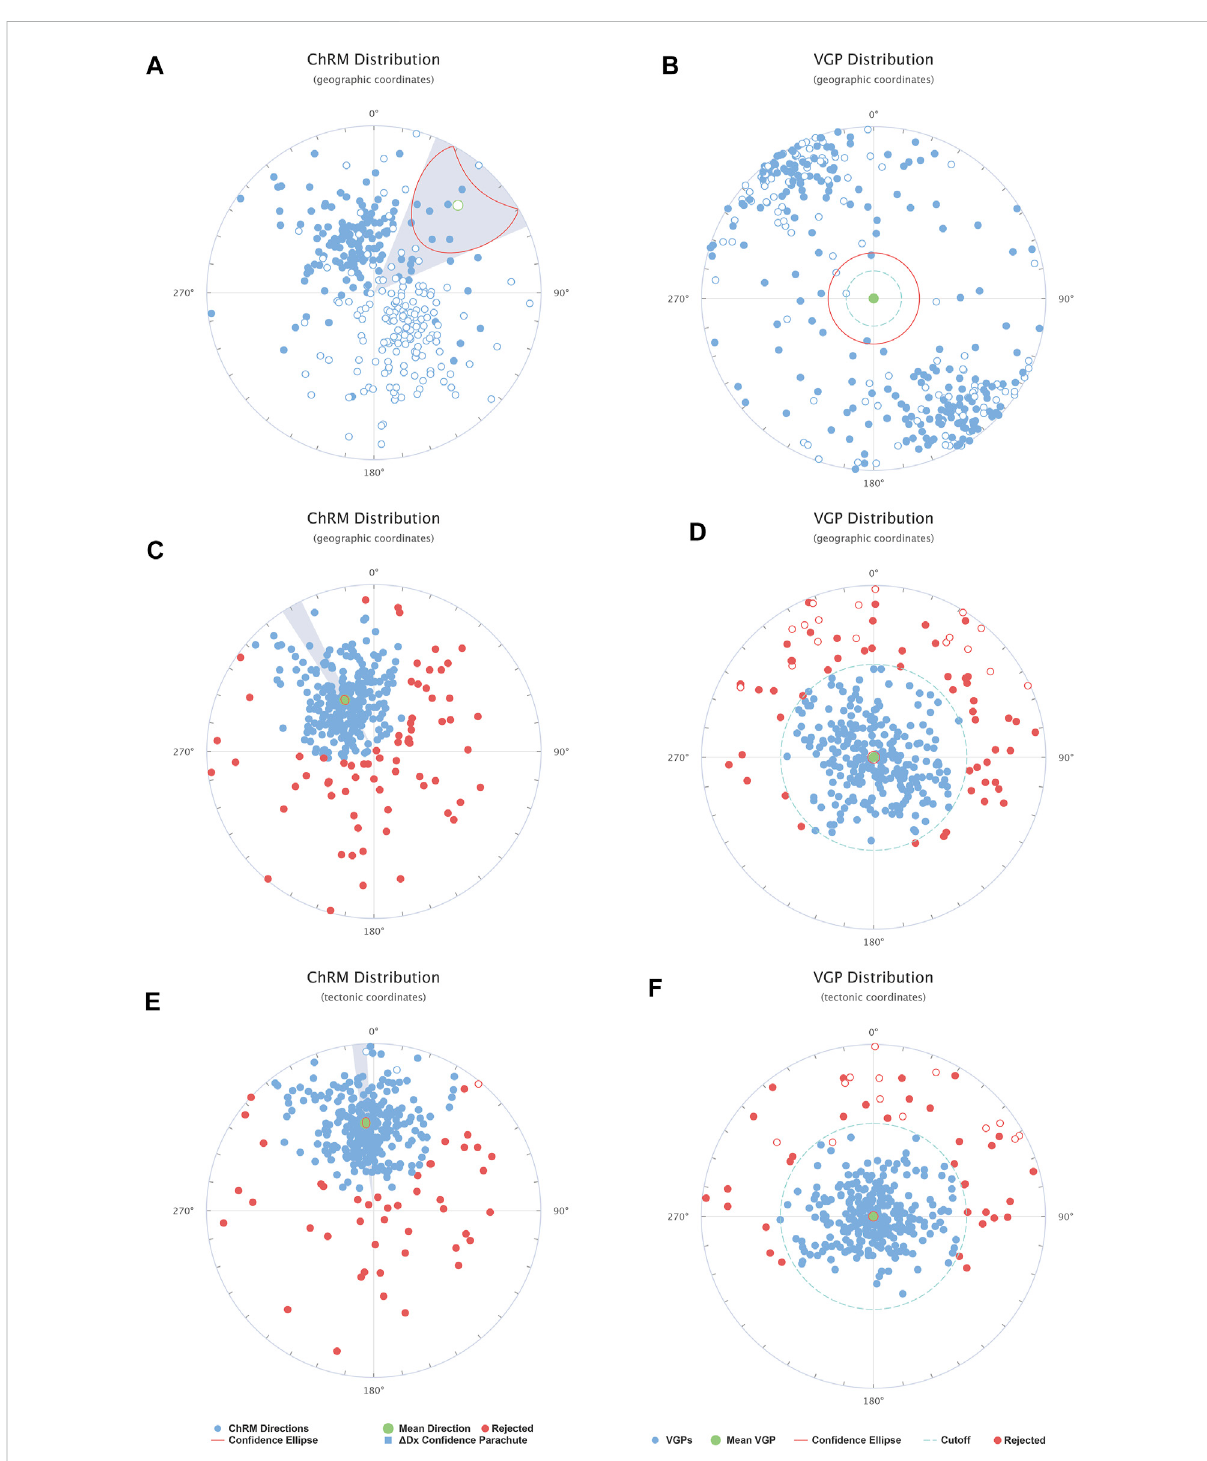
FIGURE 6 In-situ [geographiccoordinates, (A, B, C,D) ]and tilt-corrected[tectonic coordinates, (E, F) ]Equal-area stereographic projection of ChRMs and VGPs from the Yengisar section. (A) and (B) show the raw data of dual polarity. (C) , (D) , (E) and (F) show the pattern after 45-cutoff of all ChRMs contain positive and fl ipped directions.